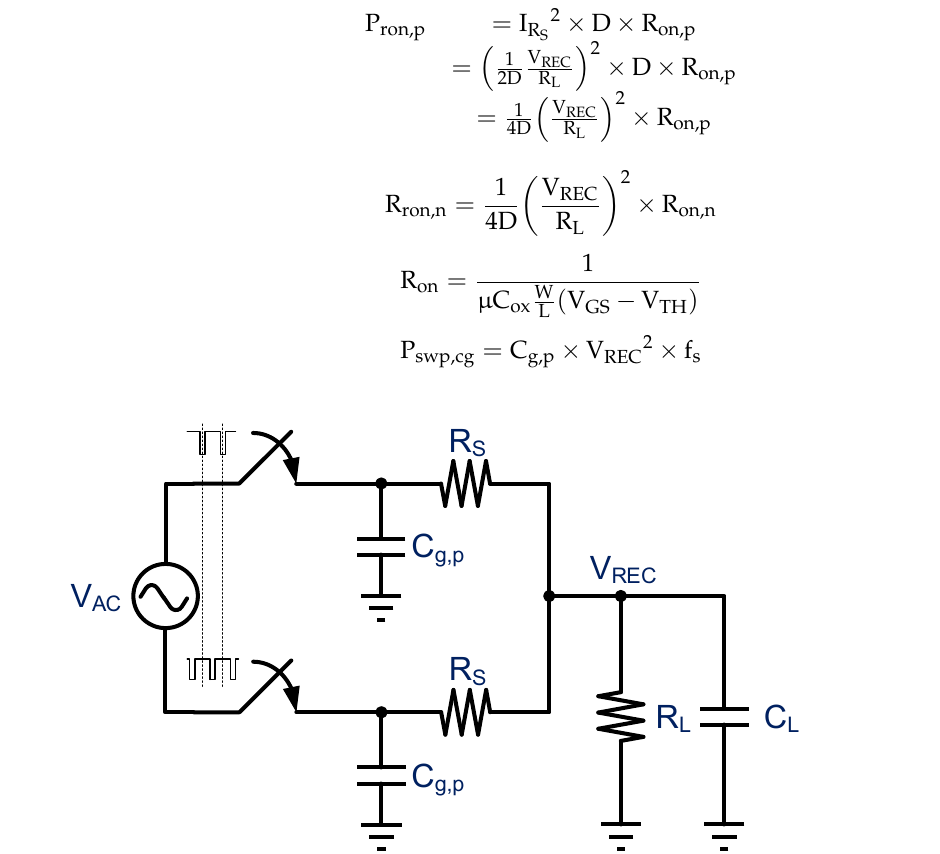
Figure 7. Calculation model for the active full-wave rectifier.